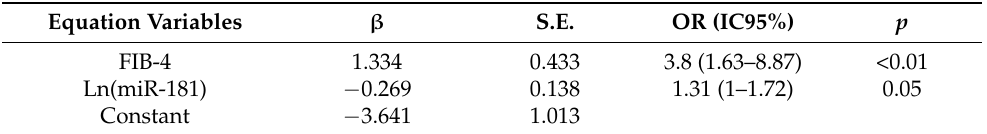
Figure 1. ROC curve of FIB-4 (Fibrosis index-4) and NFS (NAFLD fibrosis score) in fibrosis assessment. Table 5. Multivariate logistic regression model with clinically significant fibrosis (F2–F4) and predic- tors FIB-4 and Natural Logarithm of miR-181a expression.